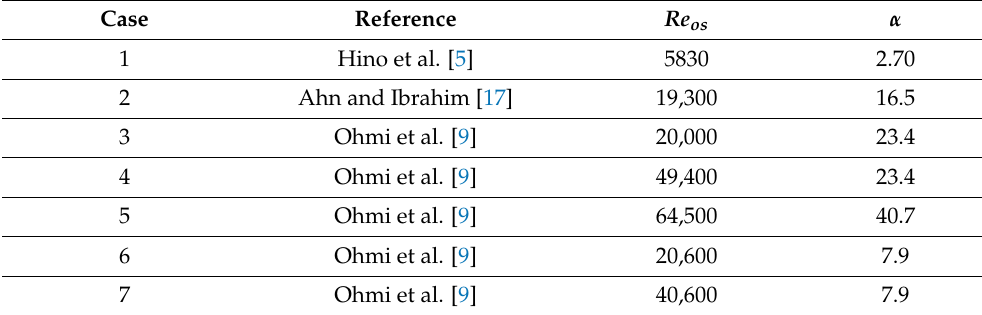
Table 1. Experimental data sets with corresponding experimental conditions that were used for validation of the computational results presented.